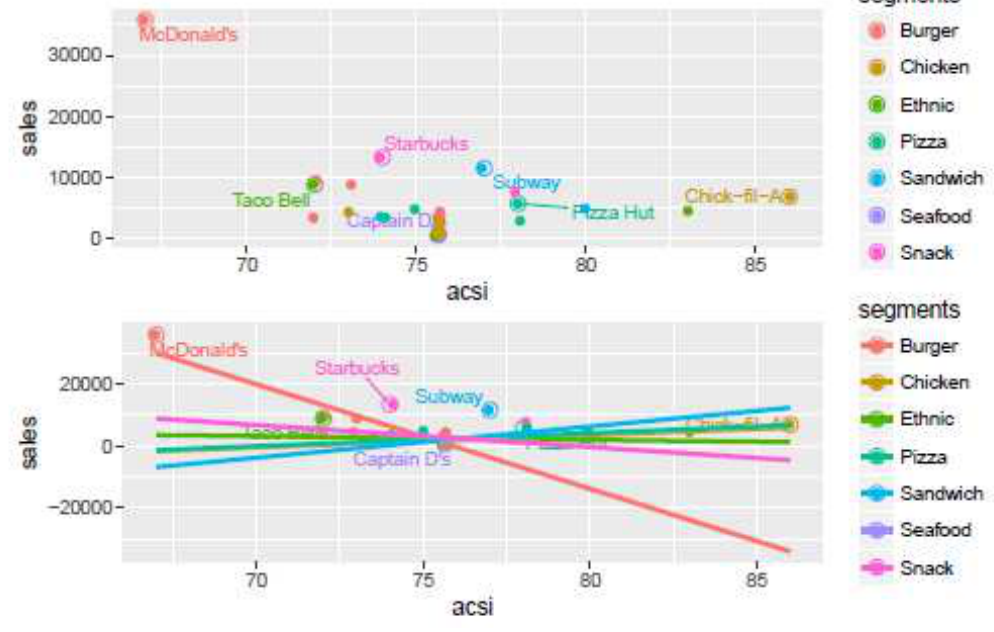
Fig. 5. QSR best-in-segment sales and by segment